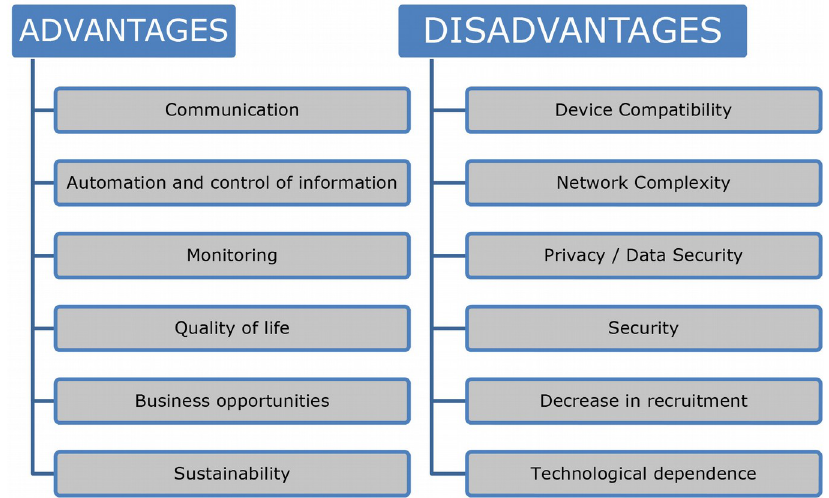
Figure 1. Advantages and disadvantages of IoT (Soumyalatha,